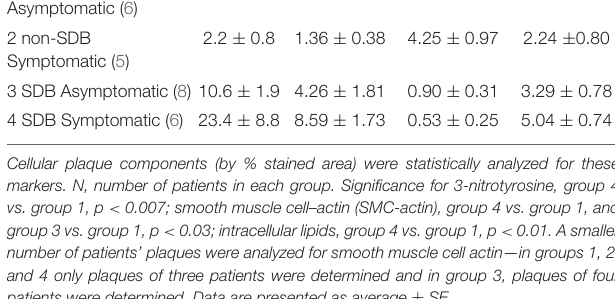
Lipids Smooth -intracellular -tyrosine muscle cell - actin